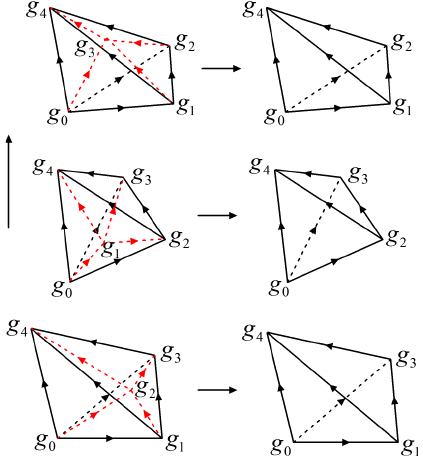
FIG. 18. All possible 3D (4-1) moves that admit a branching